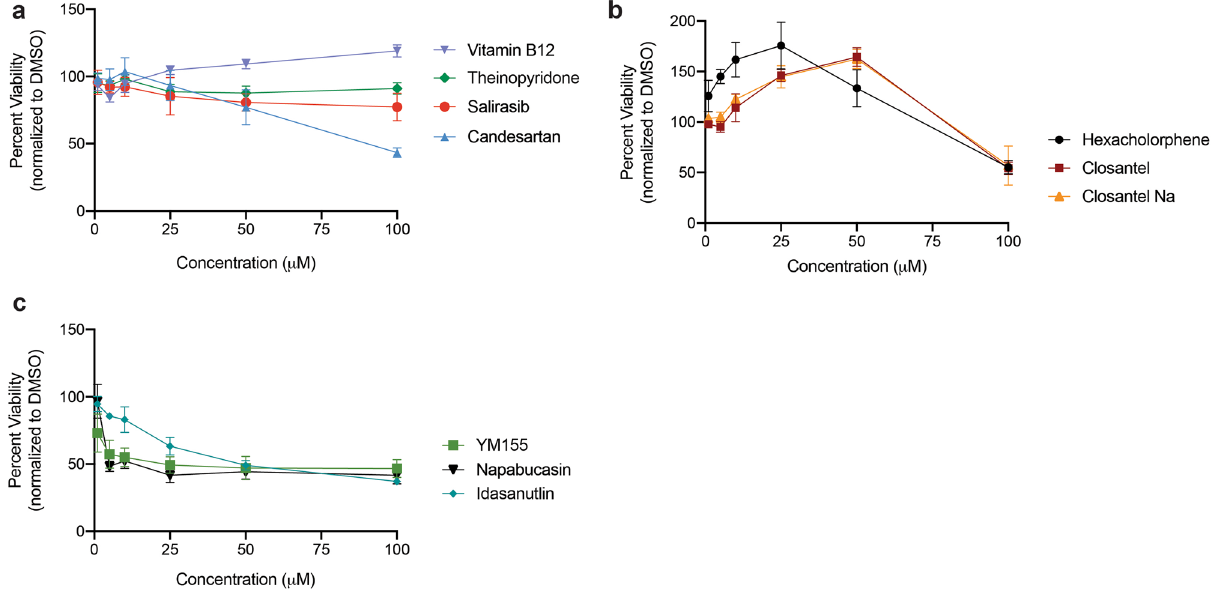
Figure 3. Salirasib and Candesartan are non-toxic PRL inhibitors. HEK293T cells were cultured with drugs at a range of concentrations and viability was assessed after 16 h. Drugs were sub-divided into those that were ( a ) minimally toxic, ( b ) caused increased viability, and ( c ) were highly toxic. Viability was measured as cellular reduction potential using MTT dye, and normalized to 1% DMSO control. Assays were run in triplicate in three independent experiments. Data represent mean viability and error bars represent standard deviation between assays.